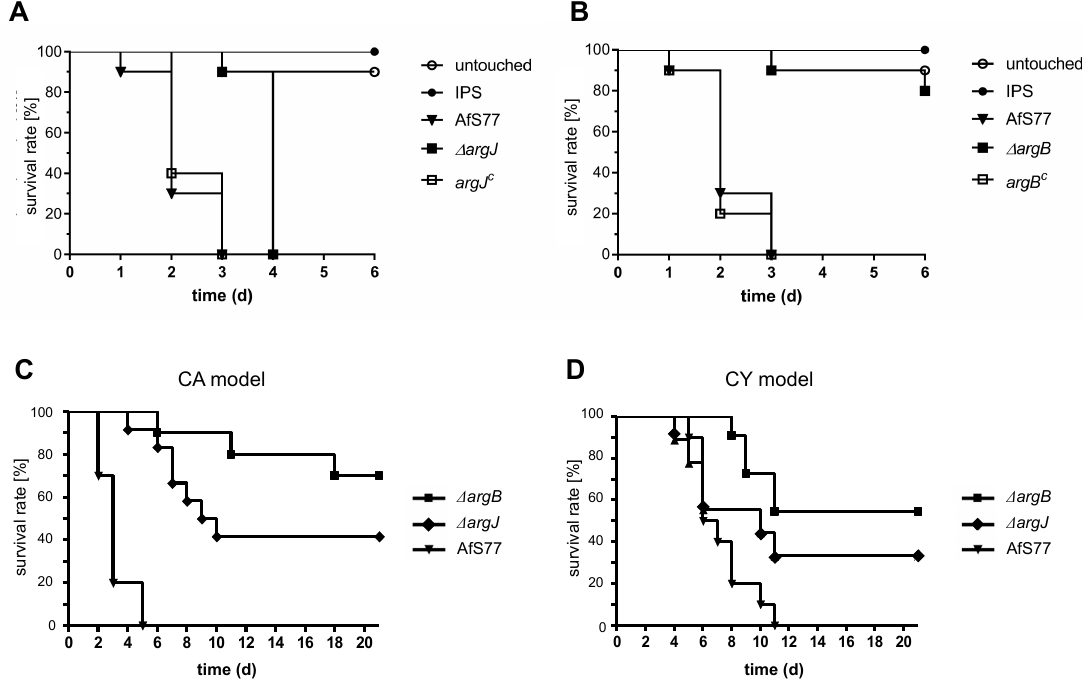
Figure 5. Lack of ArgJ and ArgB attenuates virulence of A. fumigatus in the insect model G. mellonella and in murine models for invasive aspergillosis. ( A , B ) G. mellonella larvae (n = 40 larvae per group) were infected with 1 × 10 7 conidia of the respective strains and survival was monitored for six days. Control cohorts were injected with insect bu ff ered saline (IPS, n = 20) or left untouched (n = 20). Lack of ArgJ ( ∆ argJ ) or ArgB ( ∆ argB ) attenuated virulence of A. fumigatus in G. mellonella compared to the wt and the complemented strains argJ C and argB C ( ∆ argJ , p < 0.0001 vs. wt and argJ C ; ∆ argB , p < 0.0001 vs. wt and argB C ). ( C ) Mice were immunocompromised with cortisone-acetate (CA model, non-neutropenic, n = 10 mice / group) or with ( D ) cyclophosphamide and cortisone acetate (CY model, neutropenic, n = 10 mice / group) and intranasally infected with 5 × 10 5 conidia of the wt, ∆ argJ, and ∆ argB . Survival was monitored for 21 days. In the CA model ( C ), lack of ArgJ ( ∆ argJ ) and ArgB ( ∆ argB ) attenuated virulence of A. fumigatus compared to the wt strain ( ∆ argB, p < 0.0001 vs. wt; ∆ argJ , p < 0.0001 vs. wt). In the CY model ( D ), lack of ArgB, but not ArgJ, attenuated virulence of A. fumigatus compared to the wt strain ( ∆ argB, p = 0.0002 vs. wt; ∆ argJ , p = 0.1268 vs. wt, not significant).